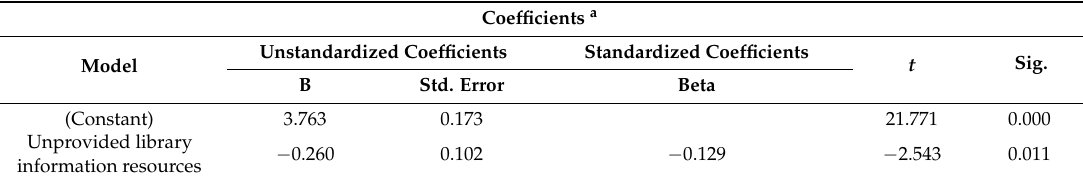
Table 7. Regression